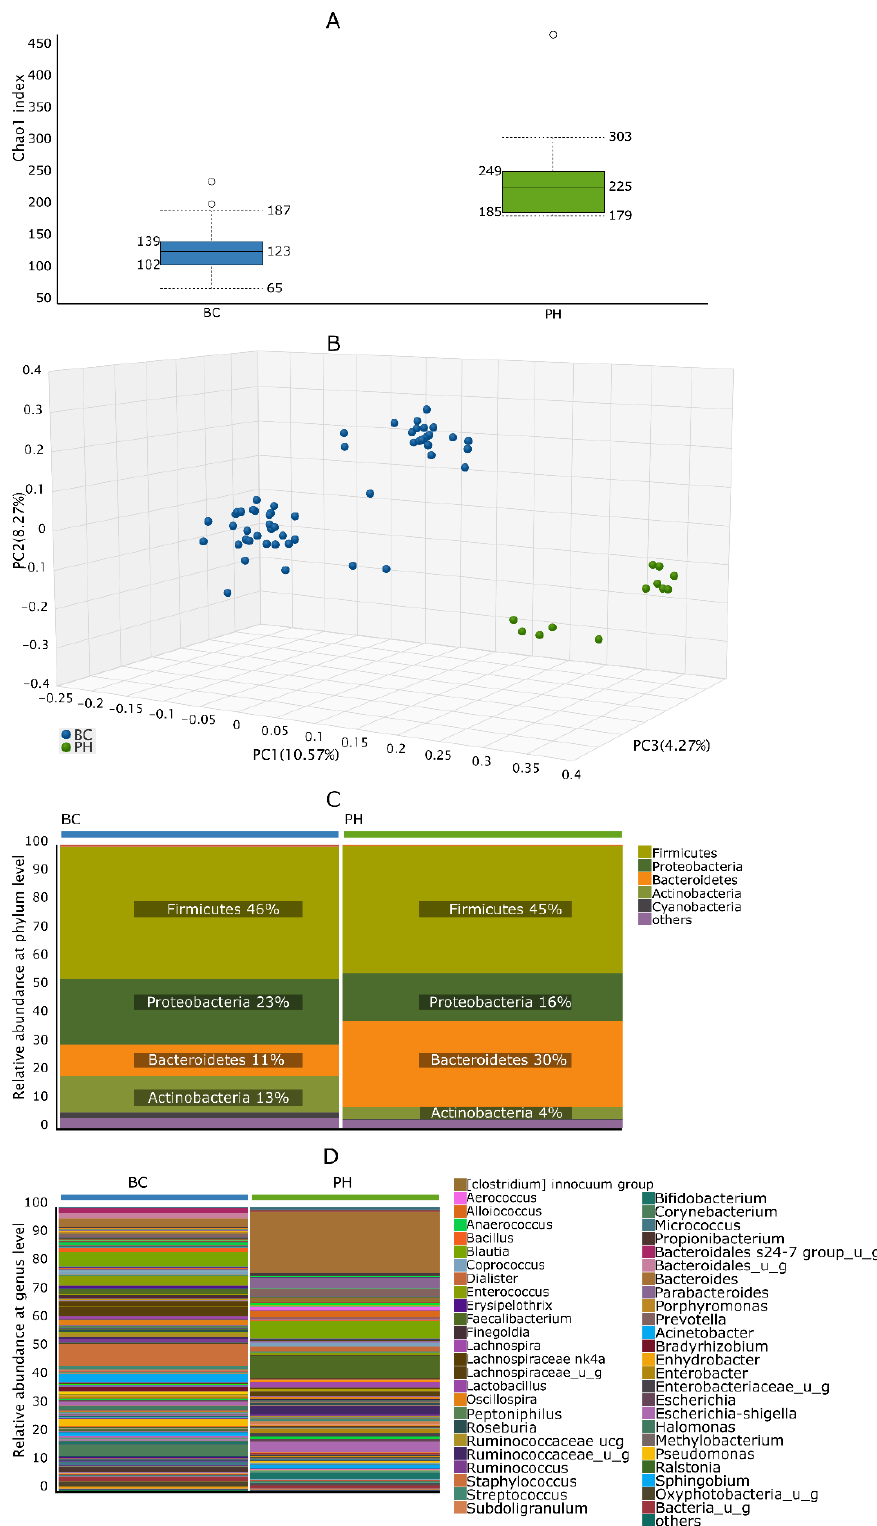
Figure 1. Comparison of tissue microbiome composition of bladder cancer (BC) and prostatic hyperplasia (PH) patients. ( A ) Chao1 alpha diversity at genus level, ( B ) Jaccard beta diversity at genus level, ( C ) taxa abundance in cohorts at phylum level, ( D ) taxa abundance in cohorts at genus level . Each urine sample collected directly from the bladder during TUR surgery was neg- ative by traditional routine aerobic culture. Samples of the PH and BC groups are sharply